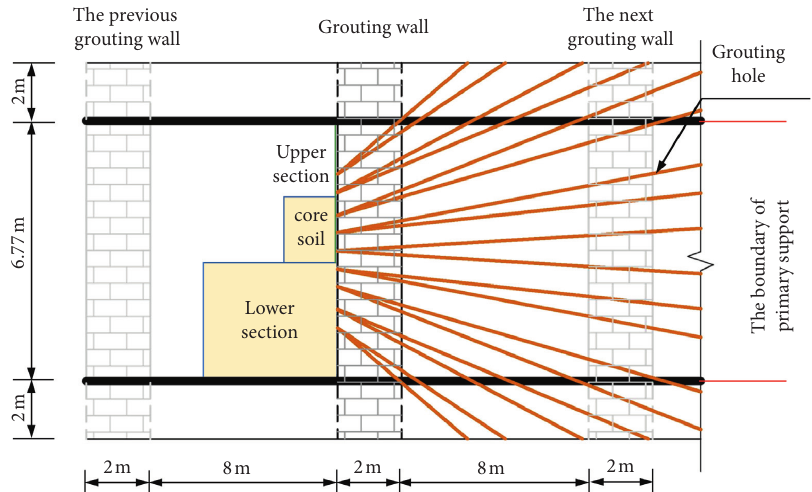
Figure 6: Pre-grouting vertical diagram.